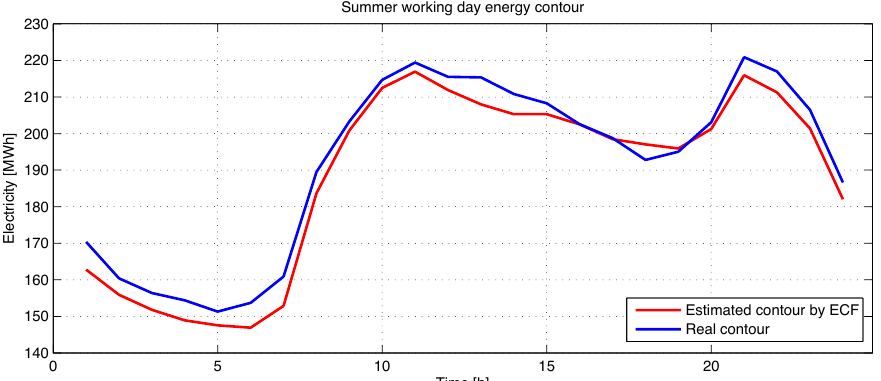
Figure 4. Estimation of energy contour by Frequency Feature Based Method (ECF) for a summer working day.